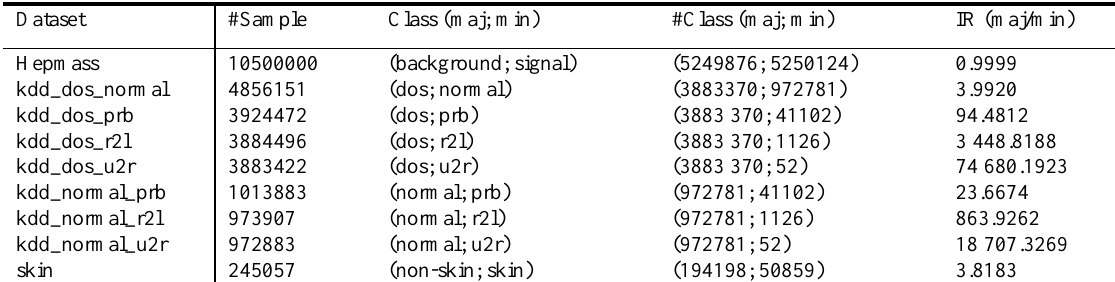
TABLE I D ETAILS OF D ATASETS U SED IN E